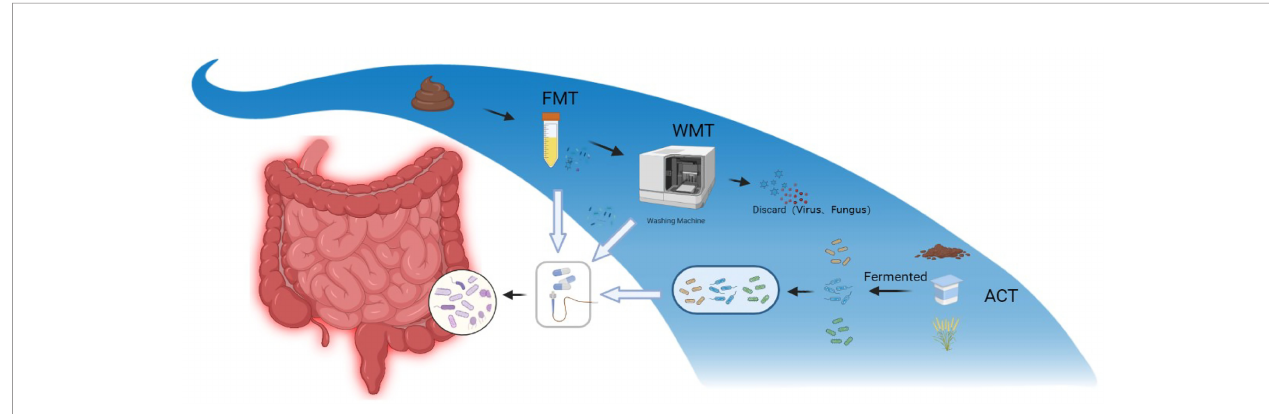
FIGURE 3 | Diagram of three different modes of microbiota transplantation. FMT, fecal microbiota transplantation; WMT, washed microbiota transplantation; ACT, arti fi cial consortium